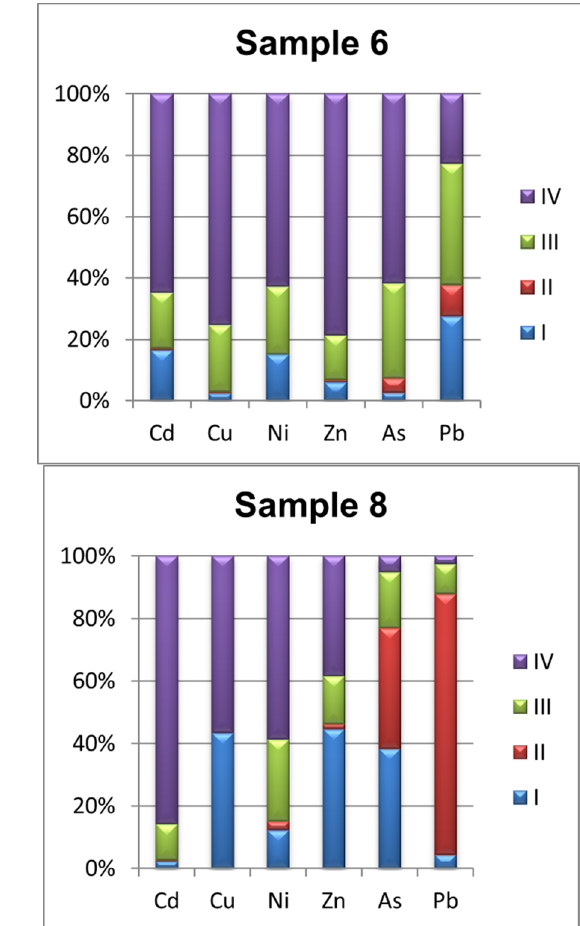
Table 8. Contamination factor values 𝐶 𝑓𝑖 of heavy metals in soil.